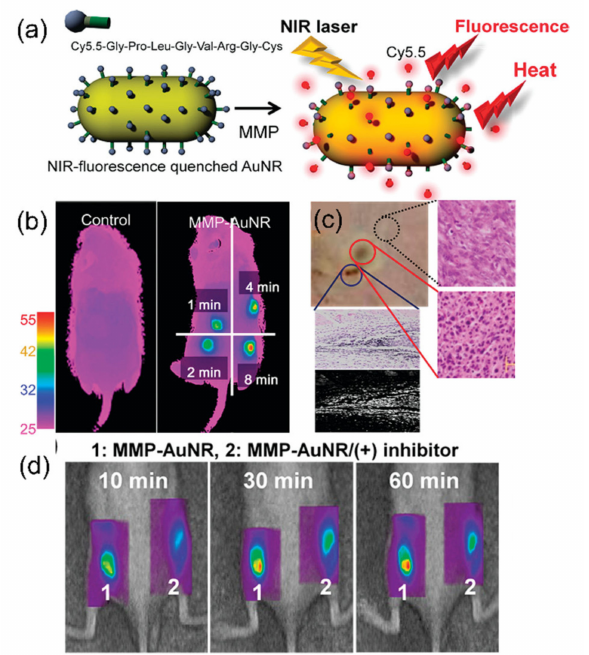
Figure 6. ( a ) Scheme of PTT agent with gold nanorods for SCC-7 tumor-specific imaging and therapy; ( b ) thermal images of tumor-bearing mice according to different laser irradiation times.; ( c ) histological analysis for tissue damage (right) and dark-field microscopic images of gold nanorods (below); ( d ) fluorescent tomographic images upon exposure to specific enzymes in cancer (1) and the inhibitor of the enzymes (2). Figures are reproduced from ref. [110] with permission from the American Chemical